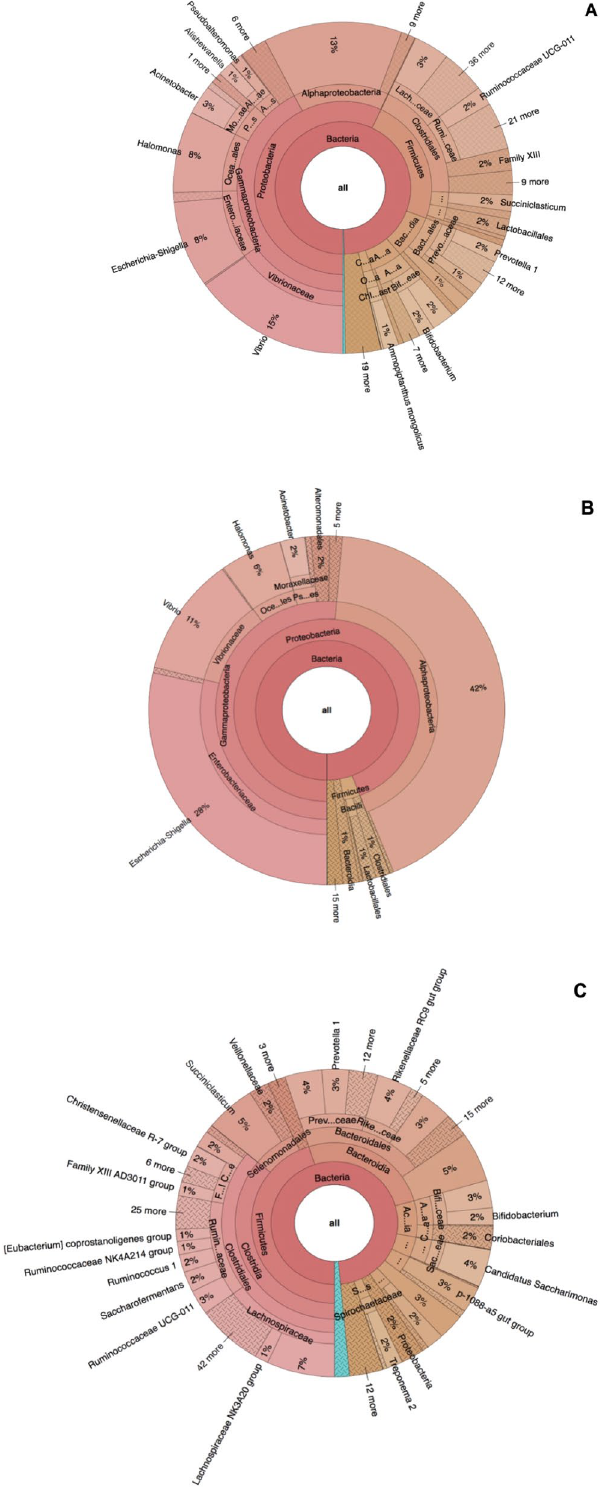
Figure 3. Krona plot for taxonomic abundance of the adult male ( A ), female ( B ) H. contortus and Abomasum ( C ) microbiome at the genus level. Data represent average values from pooled